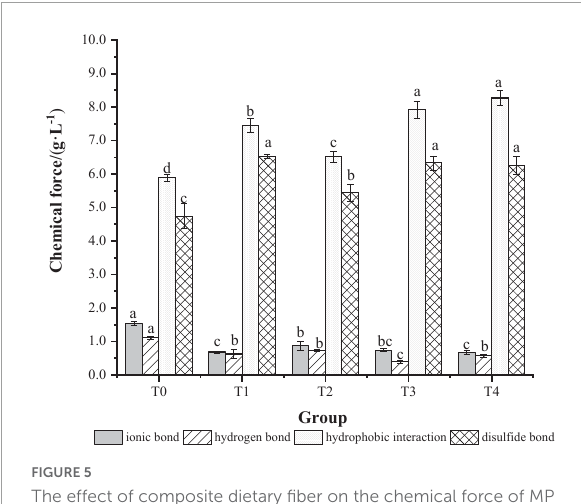
FIGURE5 The effect of composite dietary fiber on the chemical force of MP gel. T0: control group; T1: 6.06% chaff dietary fiber; T2: 6.06% soybean hull dietary fiber; T3: 6.06% inulin; T4: 1.40% chaff dietary fiber + 1.42% soybean hull dietary fiber + 3.24% inulin. a–d: Different letters indicate that there are significant differences among the samples ( P < 0.05).